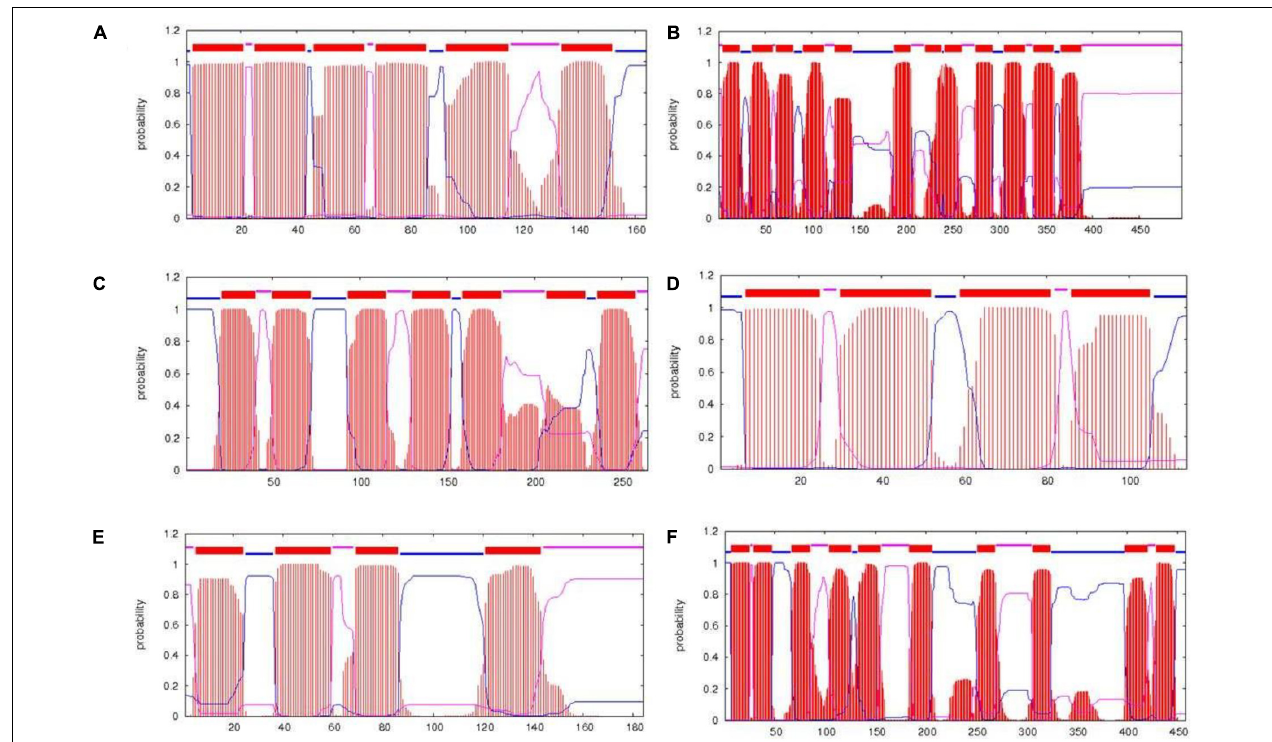
FIGURE 3 | Transmembrane structure predicted by the TMHMM server. The transmembrane domains of rod-shaped-determining protein MreD (A) , potassium/proton antiporter (B) , ABC transporter permease subunit (C) , multidrug efflux SMR transporter (D) , isoprenylcysteine carboxyl methyltransferase family protein (E), and Na + /H + antiporter NhaC (F) . Red color represents the transmembrane part, blue color represents the part of protein inside the cell, and pink color represents the part outside the cell.